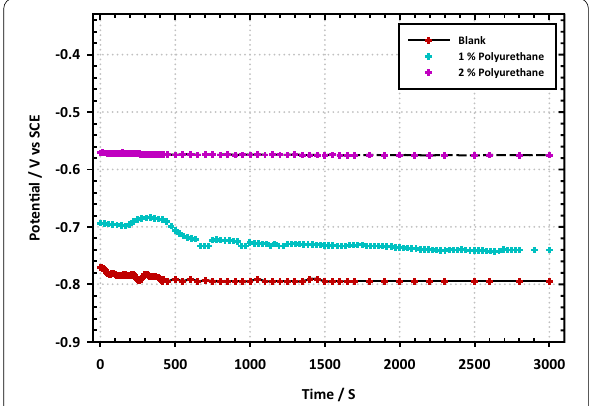
Fig. 9 Potential time variation of iron electrode in 3.5 wt% Na Cl and gradual concentration of